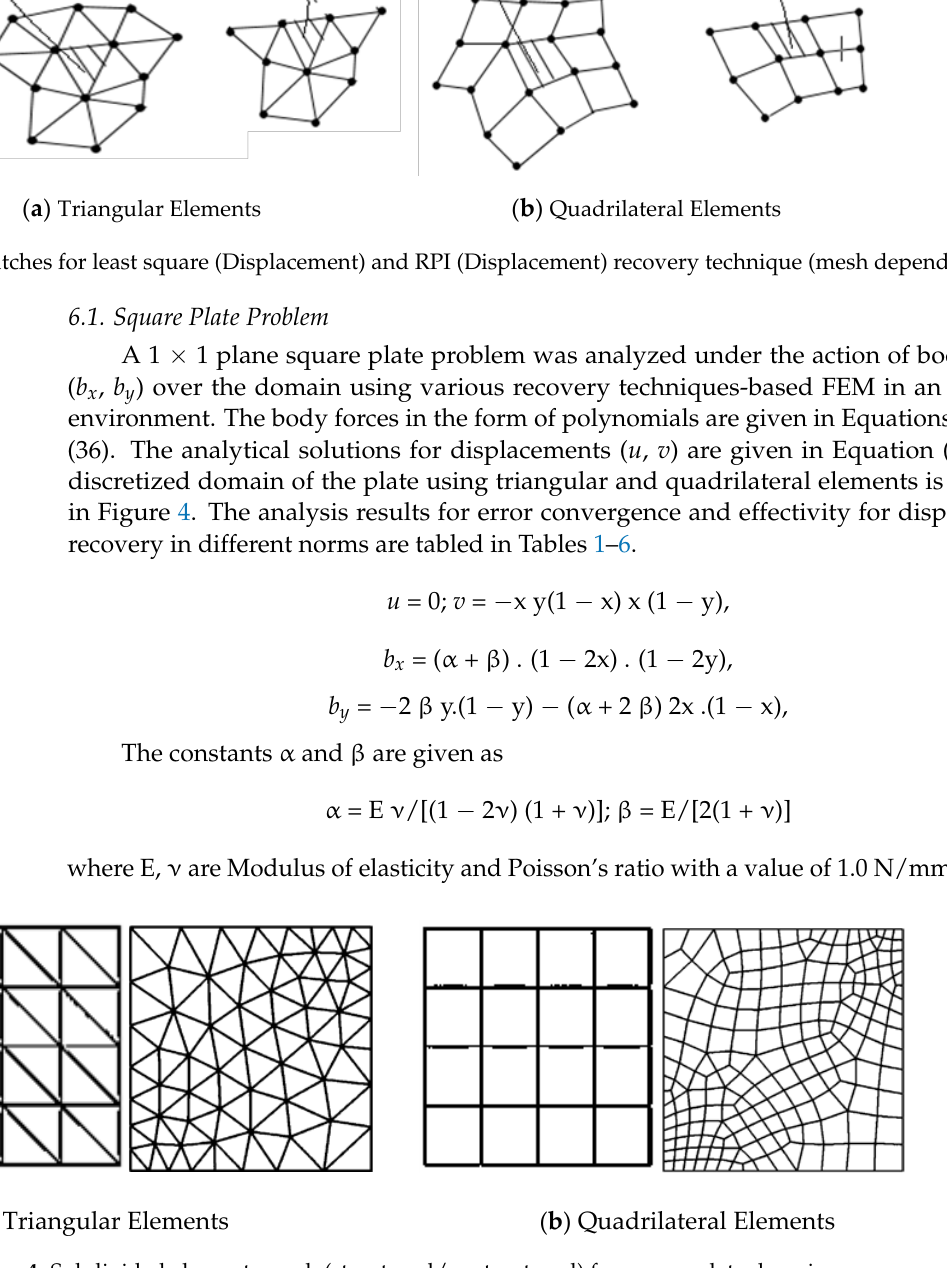
Figure 4. Subdivided elements mesh (structured / unstructured) for square plate domain. Table 1. Error convergence and global effectivity (θ) obtained for RPI (MQ) and least square based displacement recovery techniques (linear triangular, L 2 norm).